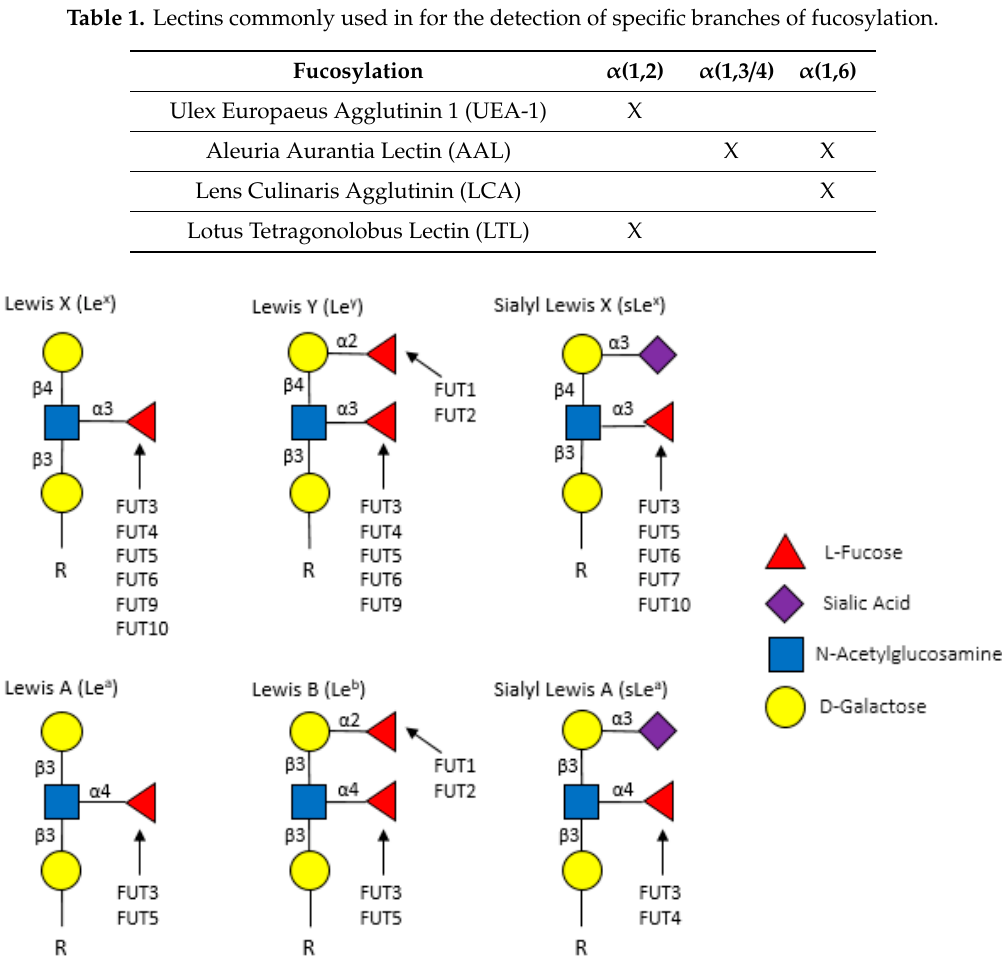
Figure 3. Lewis antigens commonly found in on the surface of cancer cells.